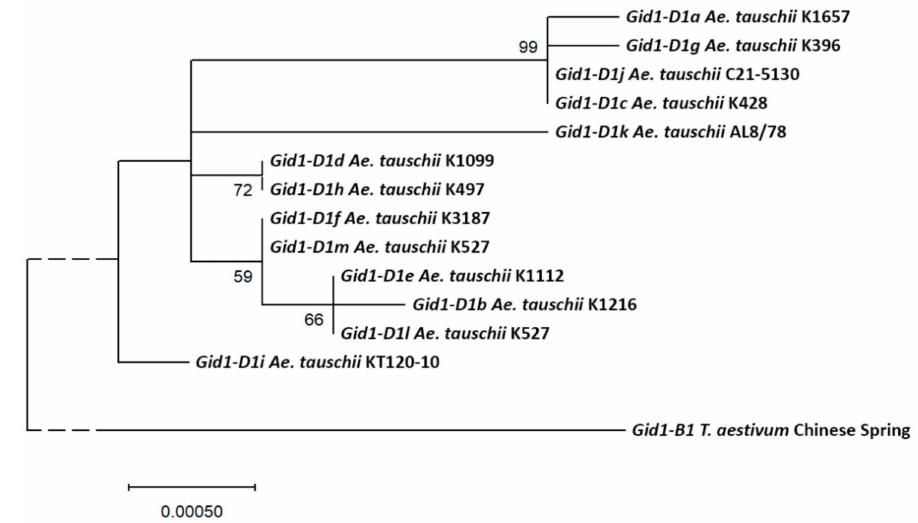
Figure 2. Molecular phylogenetic tree of the Gid1-D gene alleles of Ae. tauschii , constructed by the maximum-likelihood method. After the allele name, an example of the Ae. tauschii accession in which it was detected is given. The percentage of trees in which associated alleles clustered together in 500 bootstrap replicates is shown next to the branches. The Gid1-B gene of common wheat cv. Chinese Spring was used as an